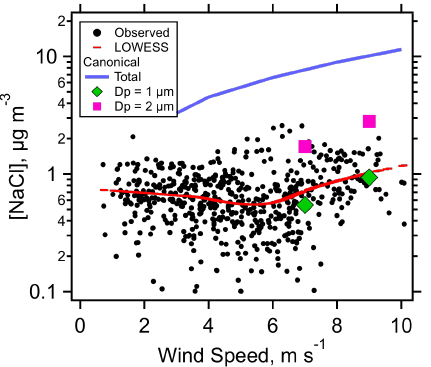
Figure 10. Wind speed dependence of MBL SSA mass concentra- tion (as NaCl) determined on the G-1 during VOCALS. The solid red line represents the LOWESS smooth of the observed NaCl con- centrations. The solid blue line represents empirical relationship be- tween the total mass of SSA (scaled to NaCl) and the wind velocity at 10m above sea surface (Fig. 17 in Lewis and Schwartz, 2004). The two sets of symbols in green and magenta represent the calcu- lated concentrations with a 1µm and 2µm upper size limit, respec-